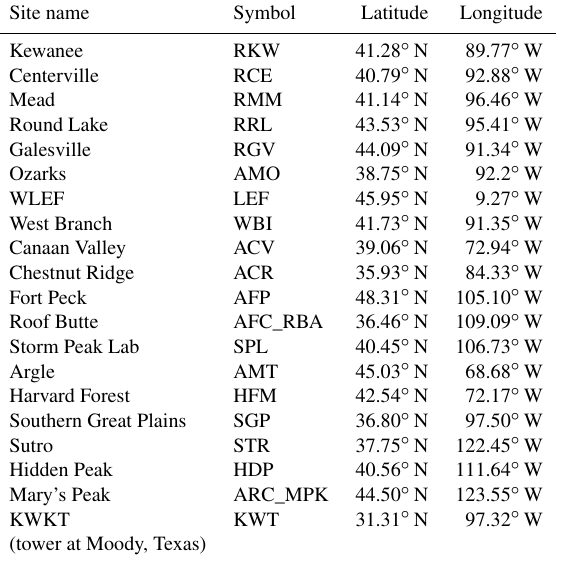
Table 4. Summary of CO 2 tower sites. Sensitivity ∂ q co2 /∂ k co2 as calculated by WRF-CO2 4D-Var’s tangent linear and adjoint mod- els is compared against finite difference sensitivity at these sites.